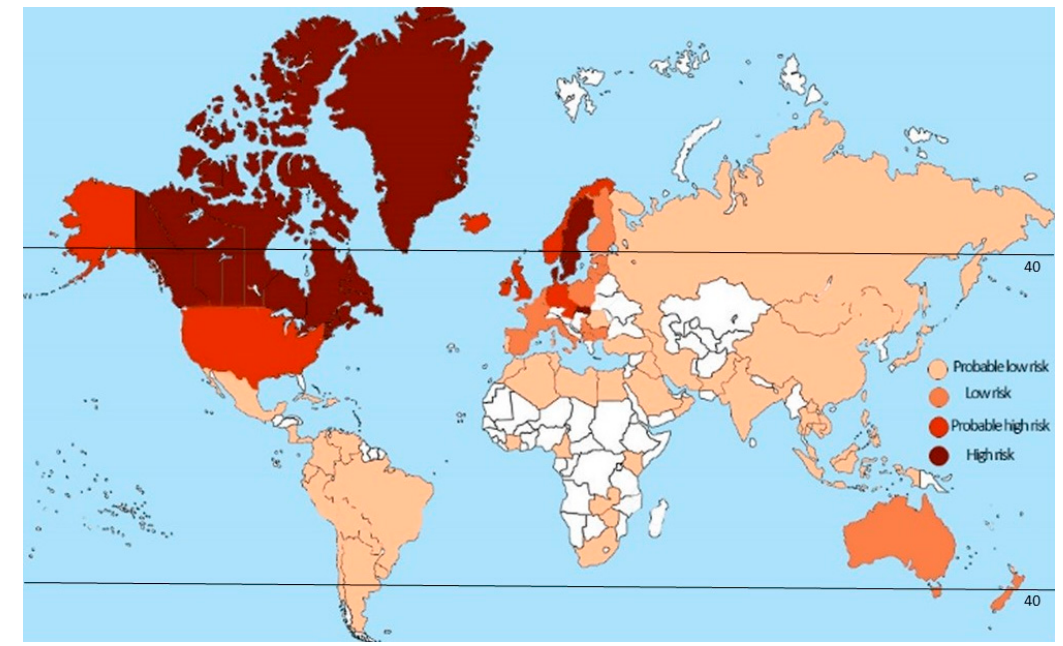
Figure 3. Global risk of development of MS. The prevalence of MS increases further from the equator in either hemisphere. Prevalence is higher in North America and Europe (291 and 232 per 100,000 respectively) and lowest in South America, Sub ‐ Saharan Africa and East Asia, at 58 per 100,000 respectively [88]. It appears that highest incidence rate is registered among patients residing above the 42° latitude.